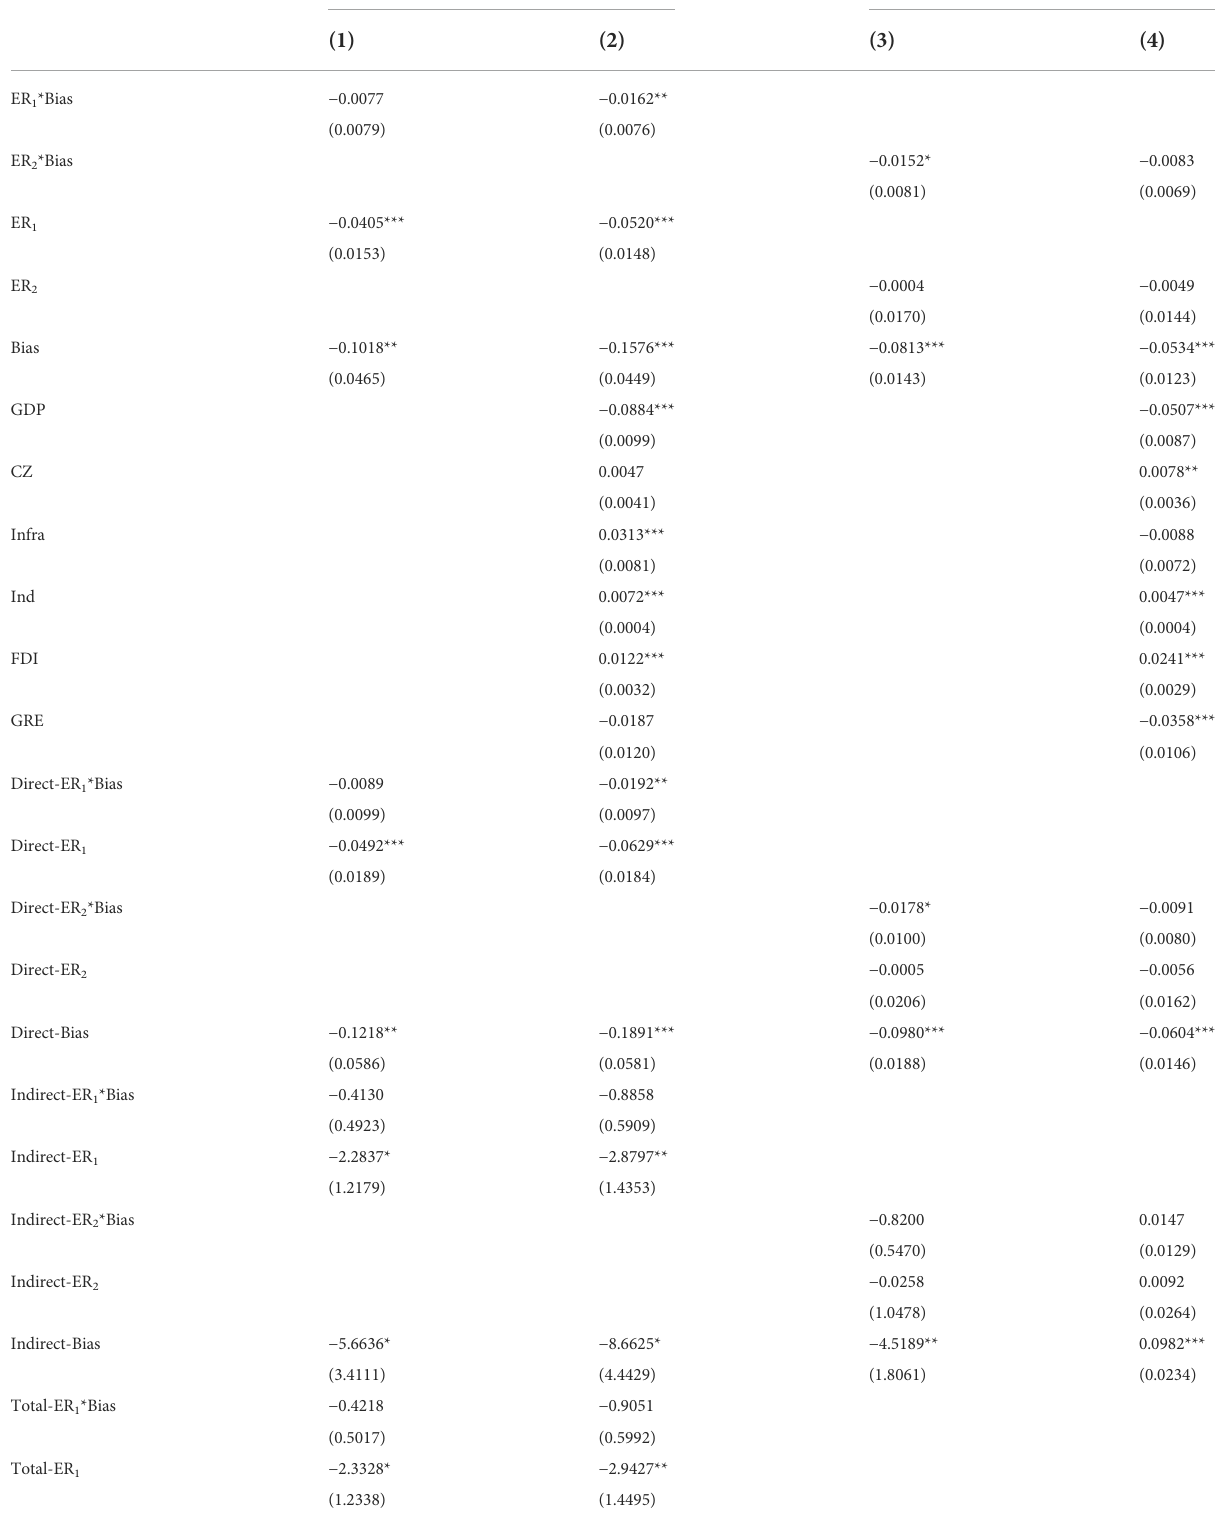
TABLE 11 Interaction effects regression